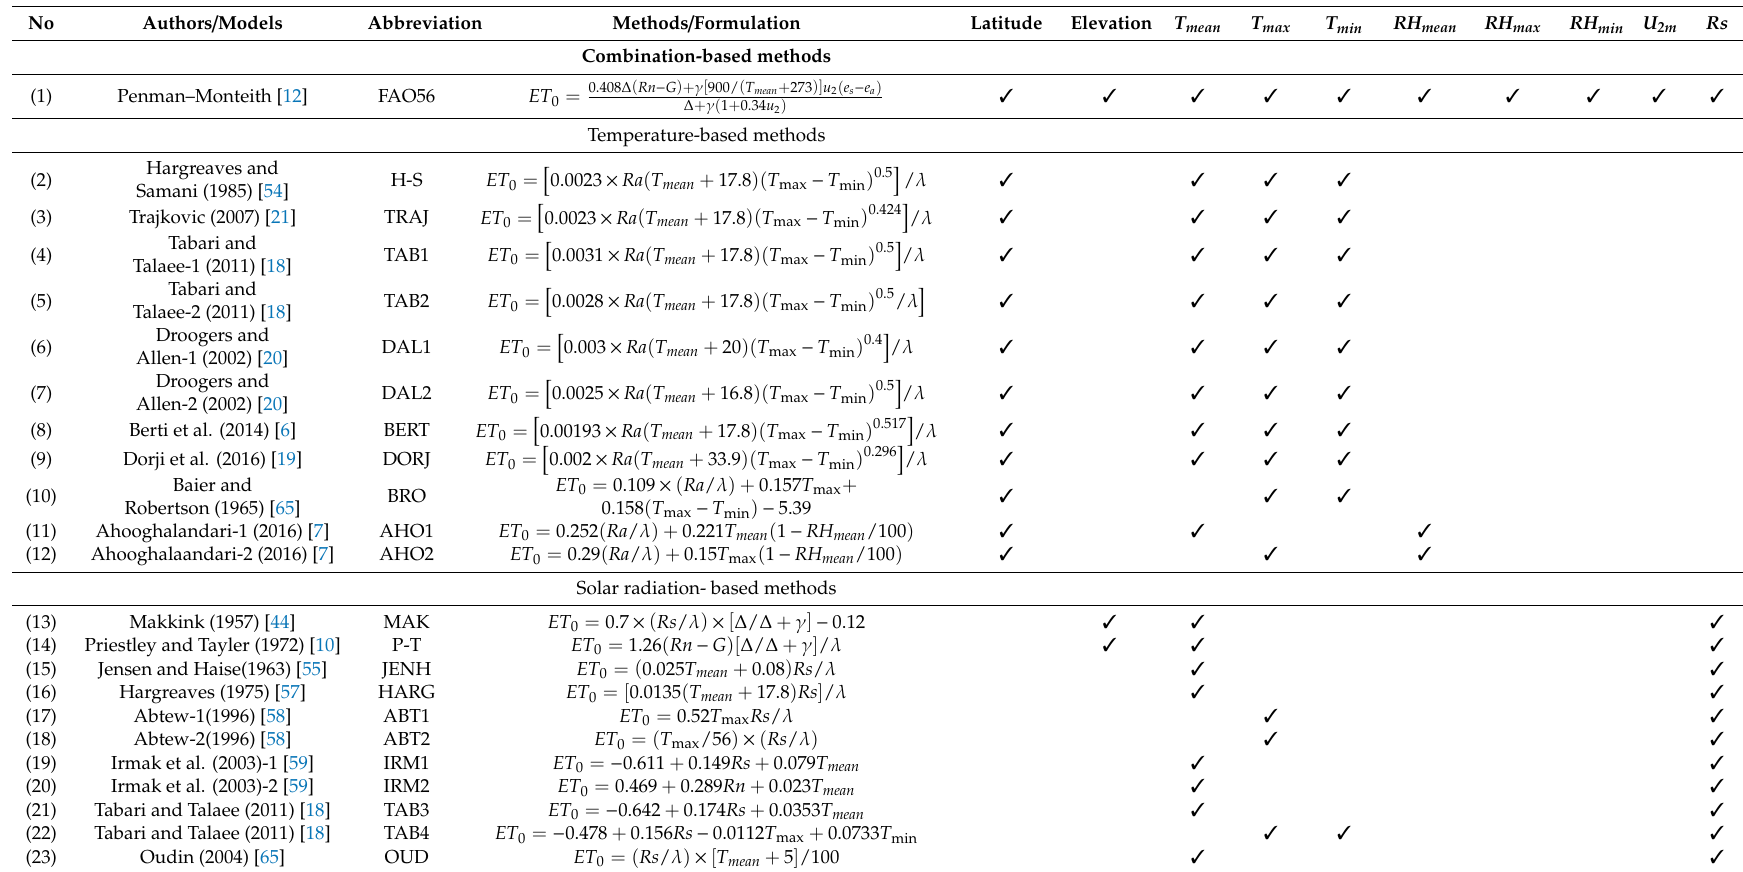
Table 2. Formulation and data requirement of the ET 0 models used in this